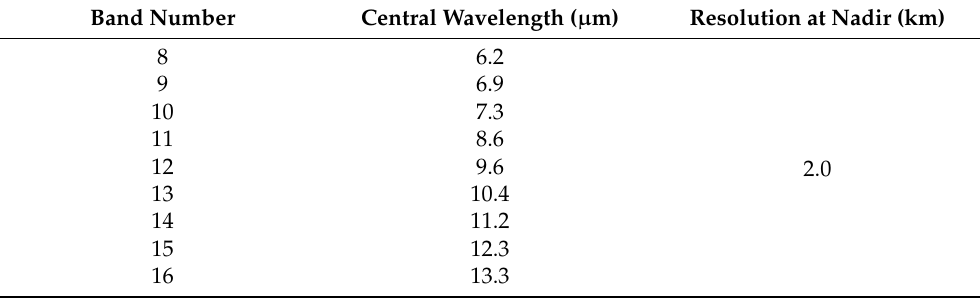
Table 1. Introduction of the AHI infrared